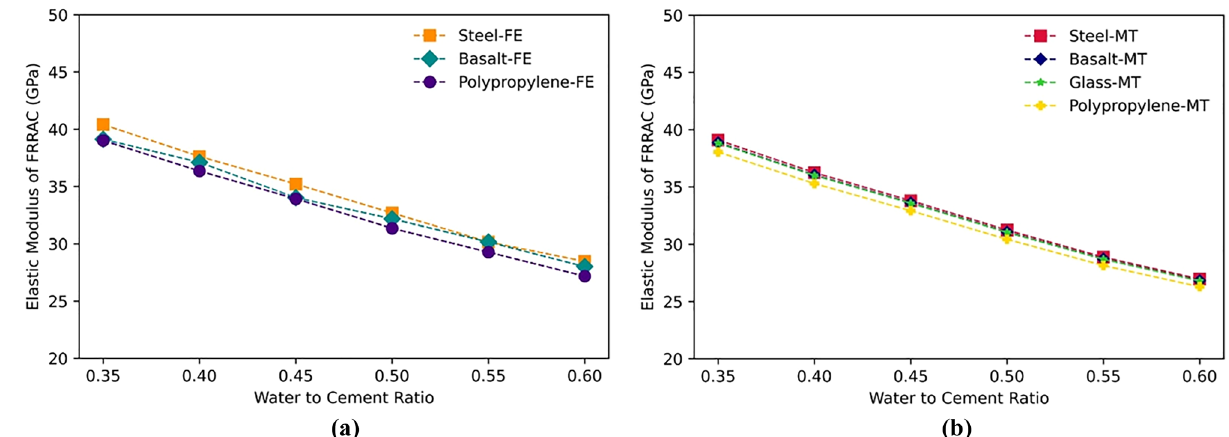
Figure 15. The elastic modulus of FRRAC based on w/c ratio: ( a ) FE approach, ( b ) MT approach.